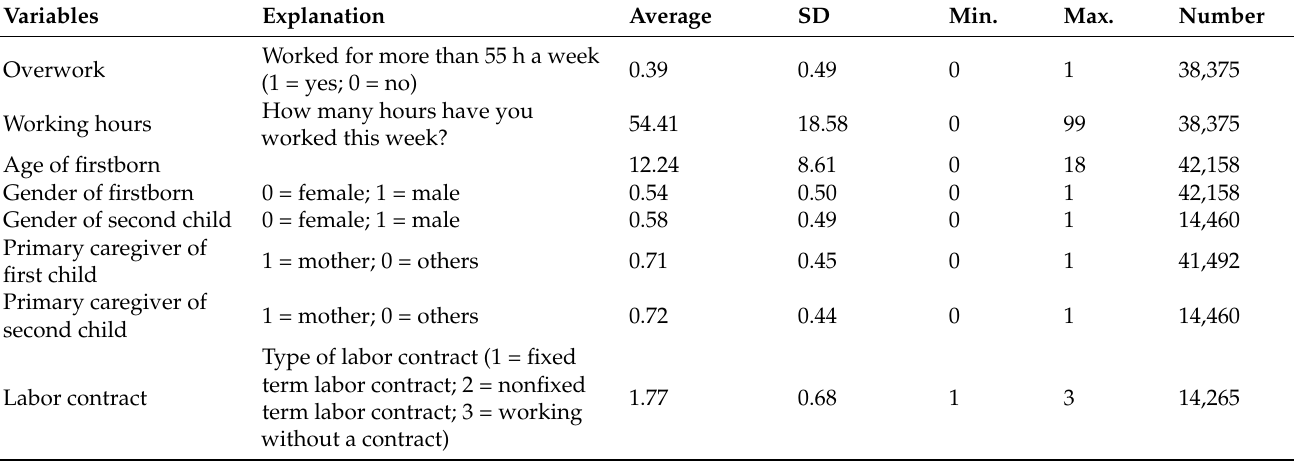
Table 1. Descriptive statistics of variable